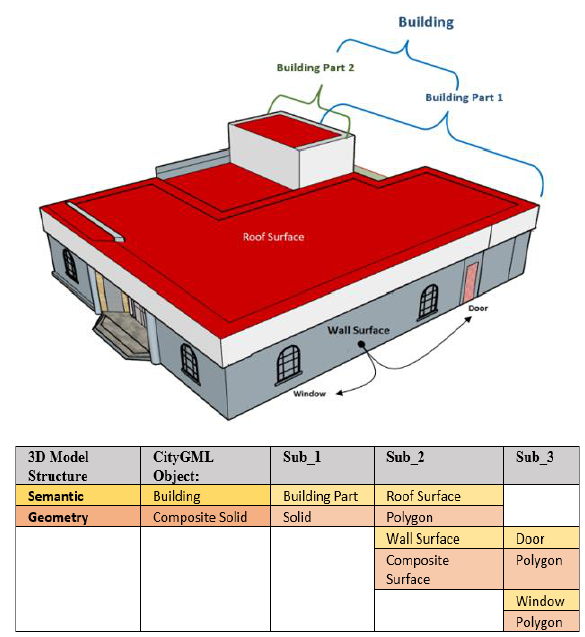
Figure 1. Decomposing the building to sub- spatial objects in CityGML 3.